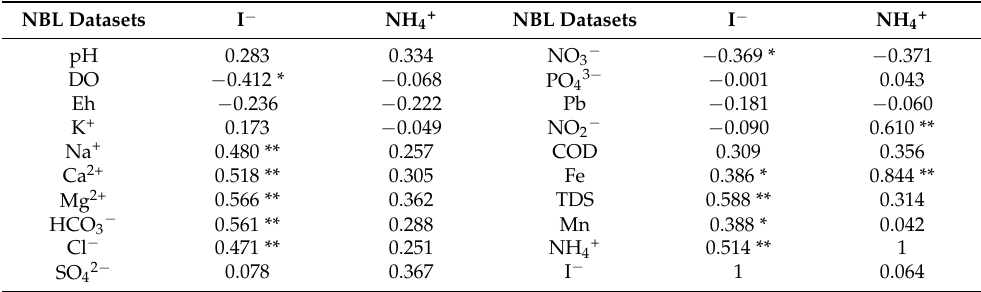
Table 2. Correlation coefficients of concentrations of I − /NH 4+ and other chemicals in groundwater unit A.